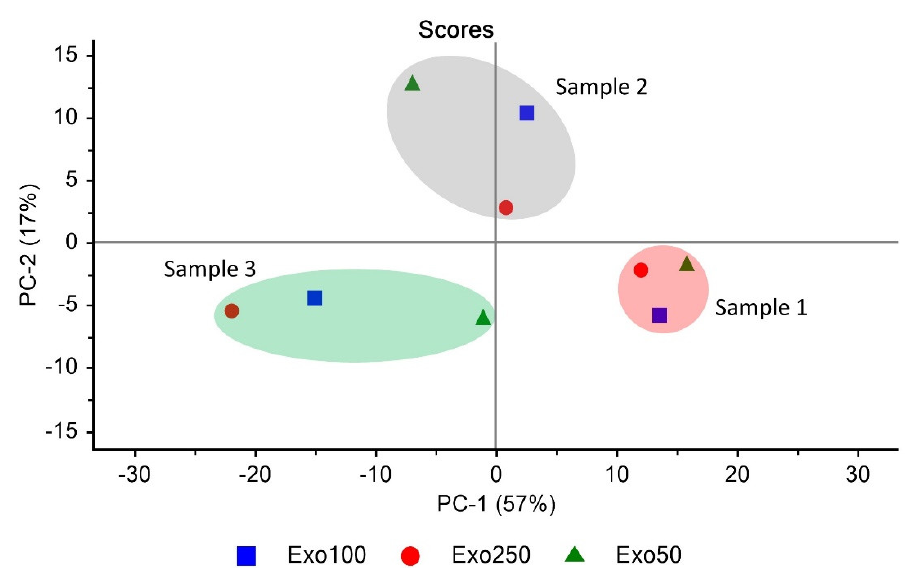
Figure 7. PCA of the exosome spectra. PCA score plots were generated using the 4000–650 cm − 1 region. There are three clusters of data, and each cluster consists of spectra from Exo50 (green), Exo100 (blue), and Exo250 (red).